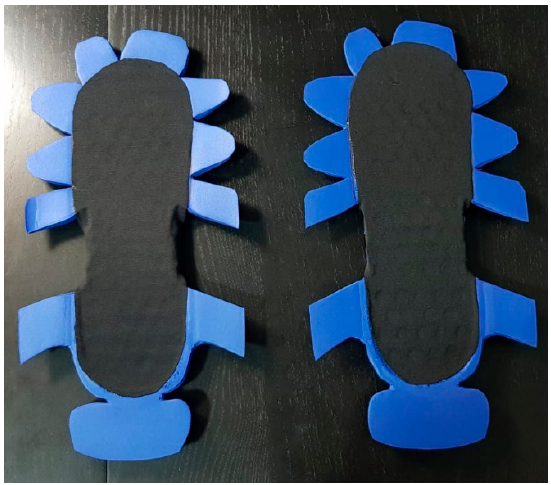
Figure 10. Modified EVA soles with surrounding ring partially removed.